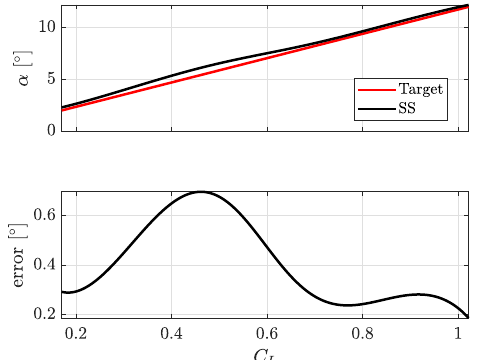
Figure 14. Estimation of C L ( α ) using the synthetic sensor trained on augmented and pruned training pattern—mean error = 0.41 ◦ , maximum error = 0.69 ◦